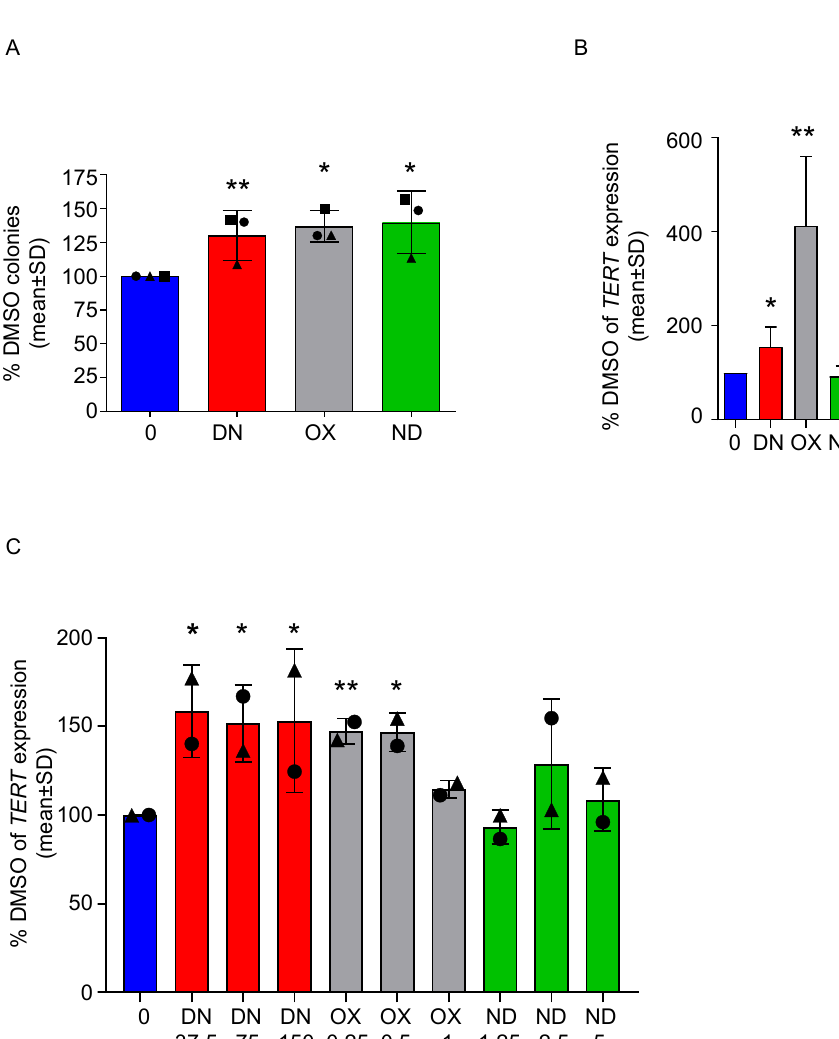
Figure 3. All ADs improve colony-forming capacity of DKC-derived BM-MNCs and danazol and oxymetholone increase the expression of TERT in PBMC of DKC patients. ( A ) BM-MNCs were cultured in a semisolid medium in presence of the highest doses of ADs depicted in the previous figure (DN 150 nM, OX 1 µ M and ND 5 µ M) versus DMSO, in order to perform a CFU assay. The number of colonies was assessed after 7 days and normalized towards the control value. One sample t-test was used to determine statistical significance. This experiment was performed with three different patient samples in independent experiments and results are showing their mean values ± SD. Patient #1 is represented with a circle, Patient #2 with a triangle and patient #3 with a square. ( B ) TERT mRNA levels in colonies obtained from the CFU assay of patient #1 were determined. Values were normalized towards DMSO values and one sample t -test was used to determine statistical significance. ( C ) TERT mRNA levels were determined in PBMC treated with ADs at different concentrations for 7 days (DN 37.5, 75 and 150 nM; OX 0.25, 0.5 and 1 µM; ND 1.25, 2.5 and 5 µM ). TERT levels were normalized towards DMSO values and one sample t -test was used to determine statistical significance. This experiment was performed with two different patient samples (patient #1, circle and #2, triangle) in independent experiments and results are showing their mean values ± SD. * p < 0.05, ** p < 0.01.